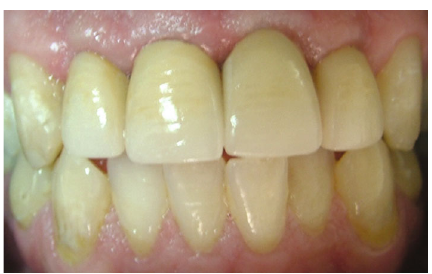
Figure 18: Placement of crowns.